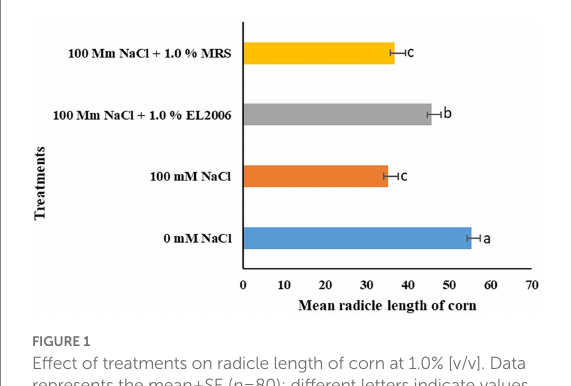
FIGURE 1 Effect of treatments on radicle length of corn at 1.0% [v/v]. Data represents the mean ± SE ( n = 80); different letters indicate values determined by Tukey’s multiple mean comparison significantly different at p < 0.05. Values with the same letters are not significantly different at p < 0.05.